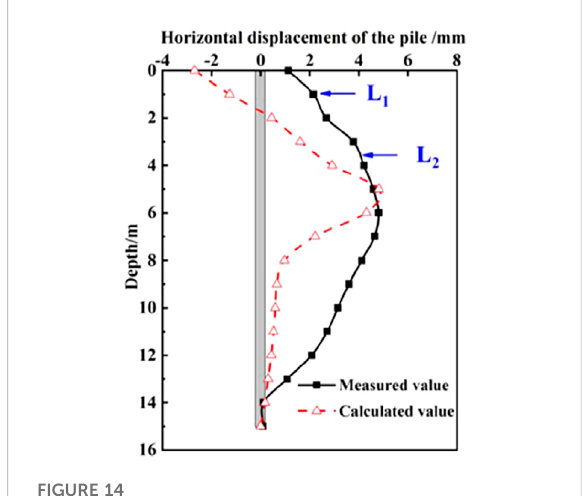
FIGURE 14 Horizontal displacement comparison curve of retaining pile.